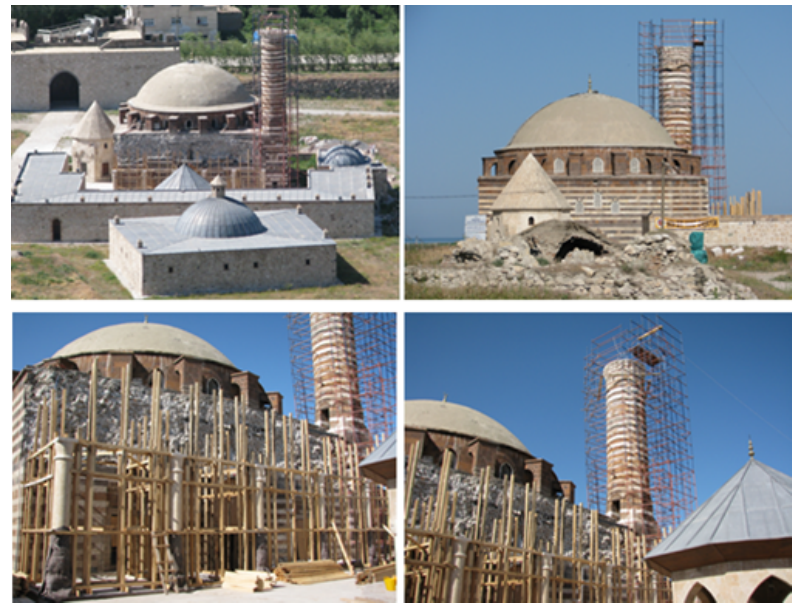
Figure 2. Damaged views of the Hüsrev Pasha Mosque.